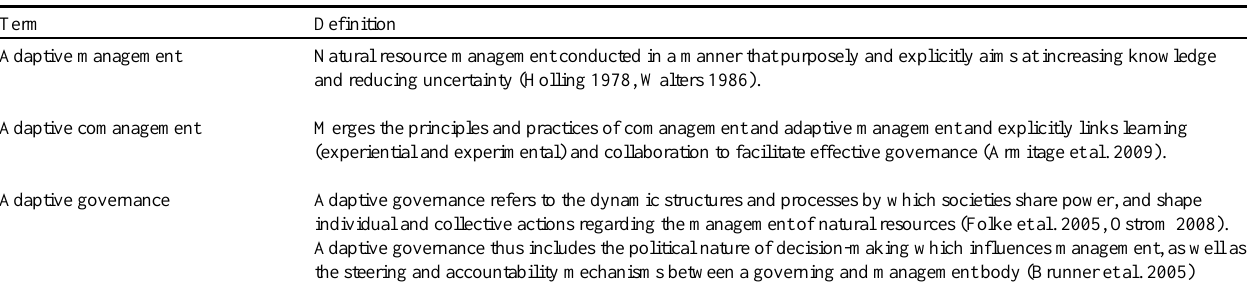
Table 1 . AM-related concepts that have developed to emphasise a focus on participation or democracy in natural